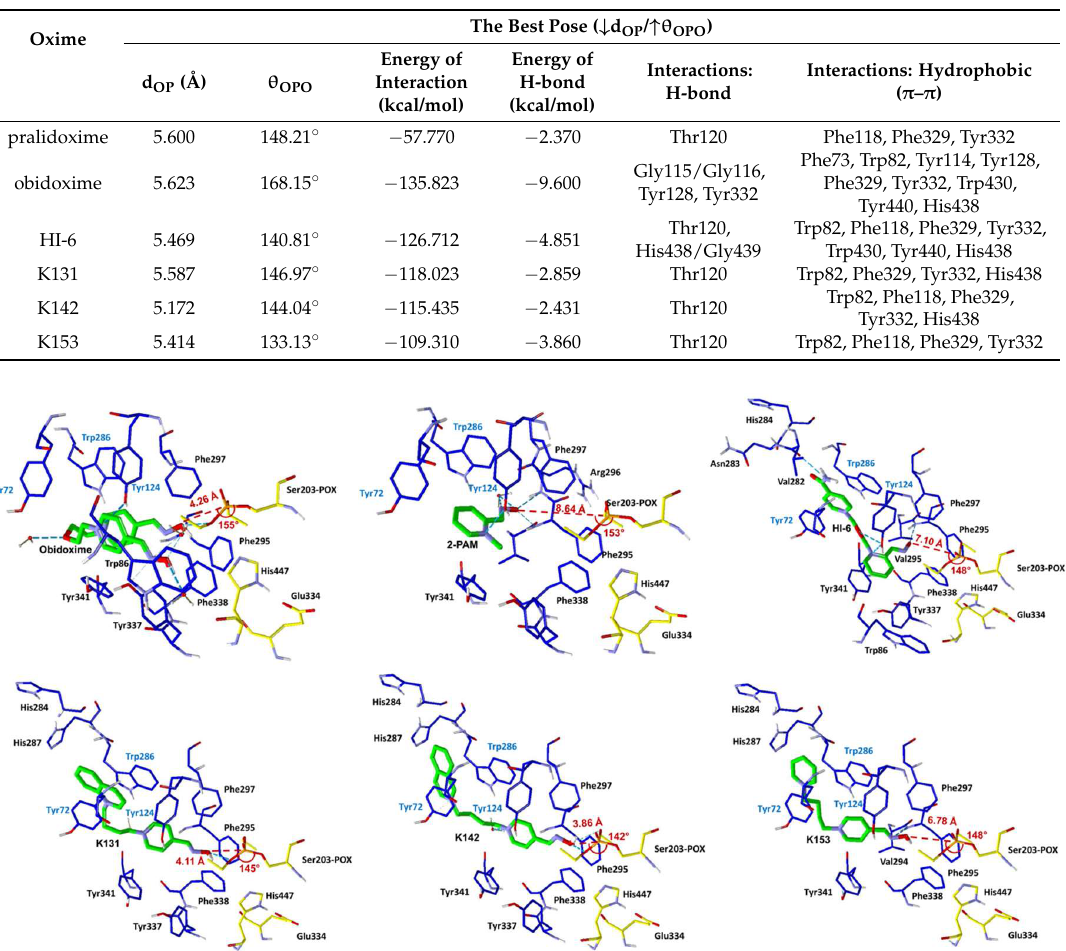
Figure 4. Best poses of the oximes inside the complex Hss AChE/POX. Distances P OP − O Ser203 and angles O ox − P OP − O Ser203 are shown in red.